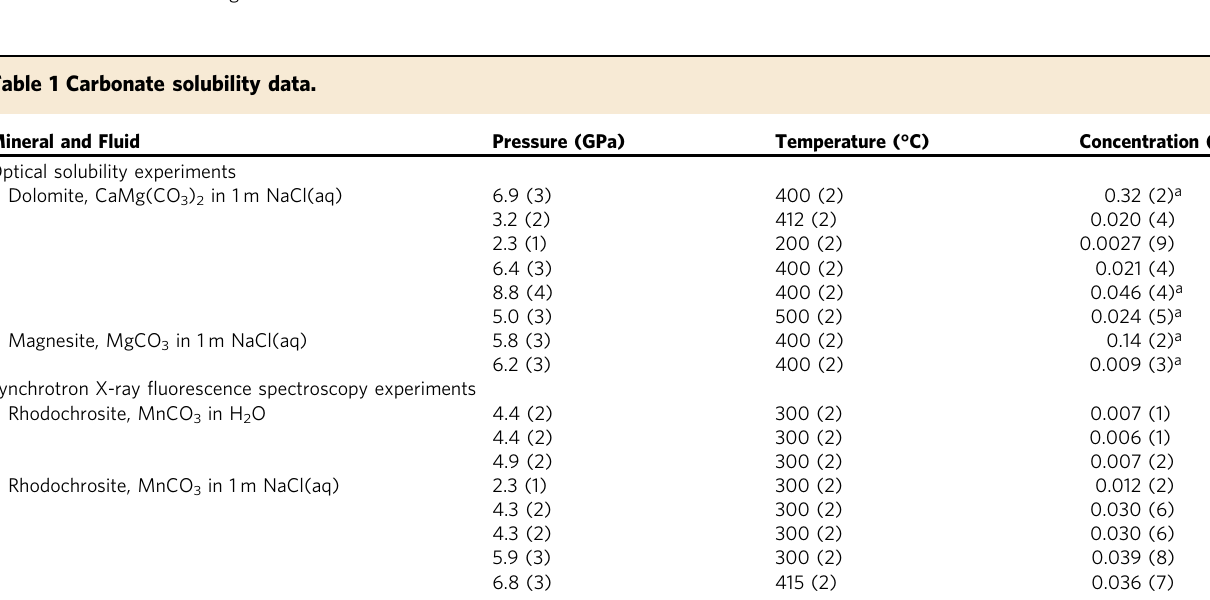
Fig. 2 Experimental determinations of carbonate mineral solubilities. Solubility is reported as a function of pressure and temperature in water or aqueous solutions of different ionic strength: a present data, b literature data. Only studies at pressures of 1 GPa or more are included. Full symbols indicate upper limits for solubility. The solid line represents a solubility line for dolomite at 400°C in 1m NaCl aqueous solution. Since no magnesite crystals dissolved, the dashed line represents an upper solubility limit for magnesite at 400°C. All solubility lines are guides to the eye. Error bars shown for our data represent estimated standard deviation. Note the log scale.